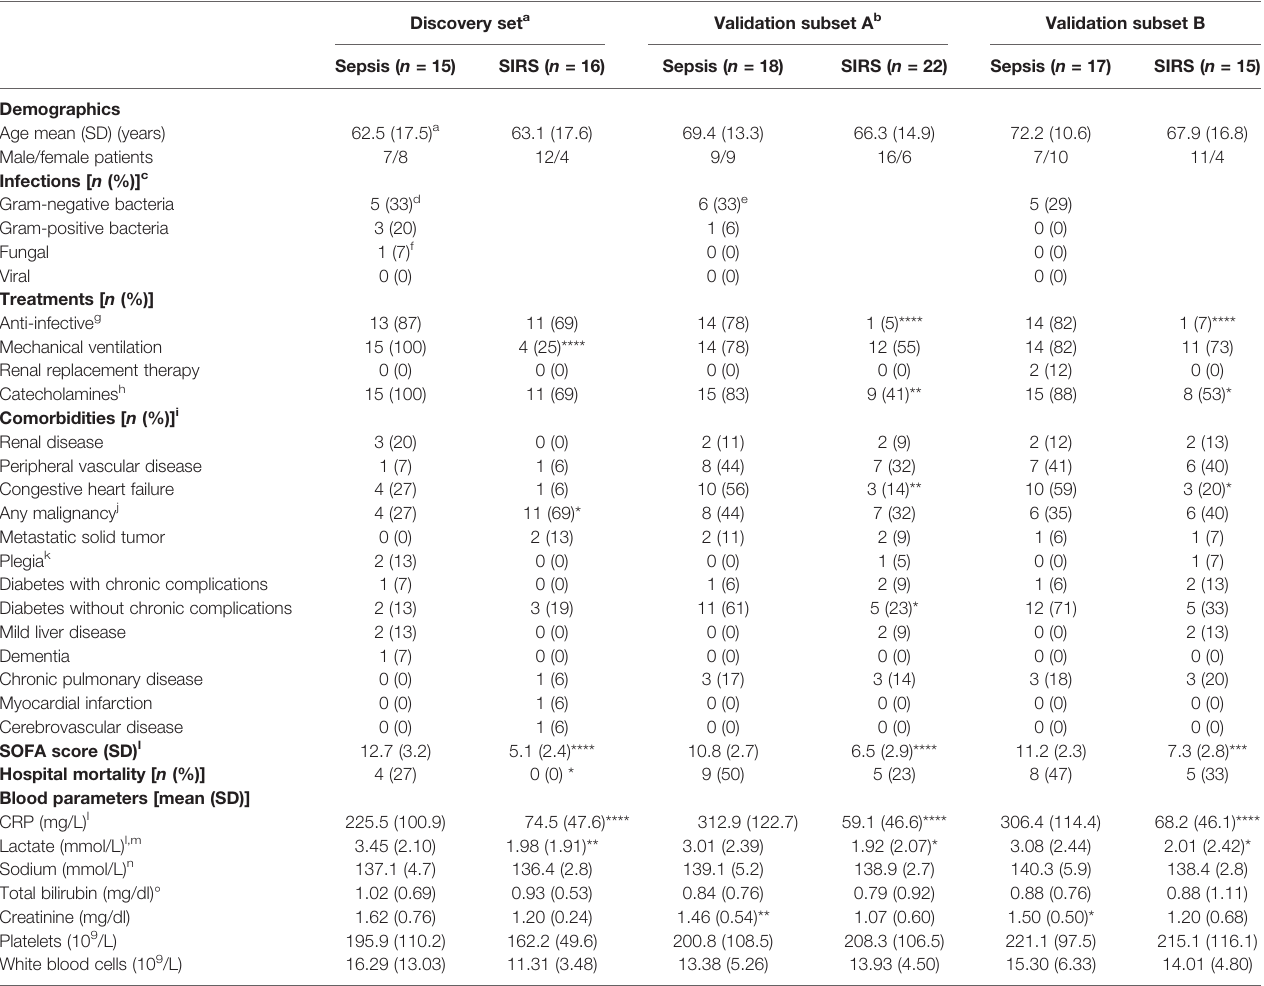
TABLE 1 | ICU patient clinical characteristics for discovery and validation of differential gene